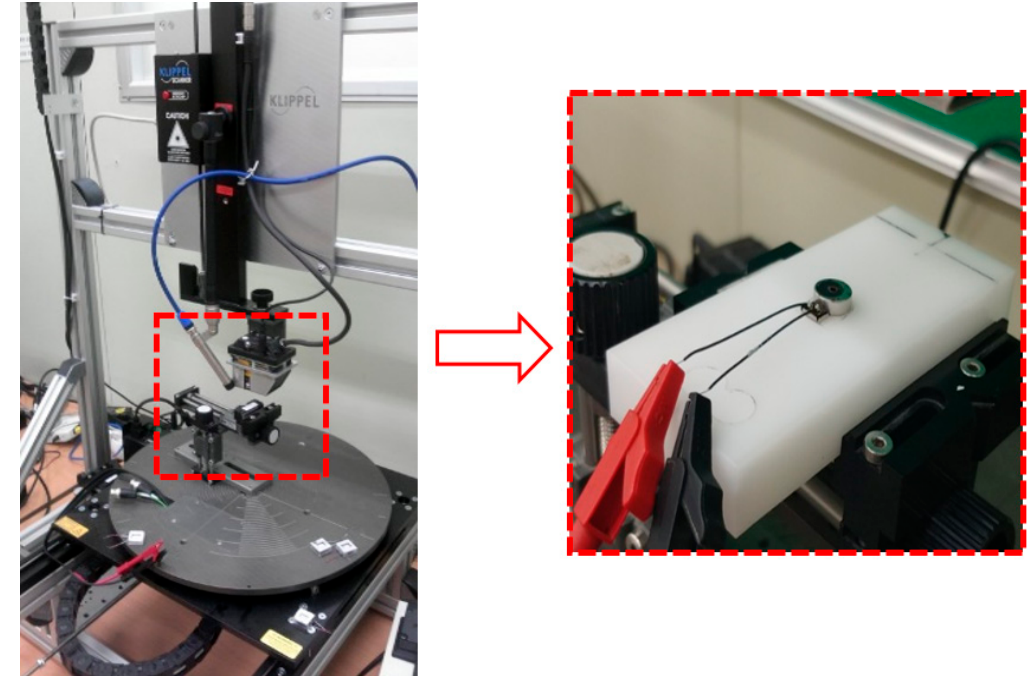
Figure 9. Experimental conditions.